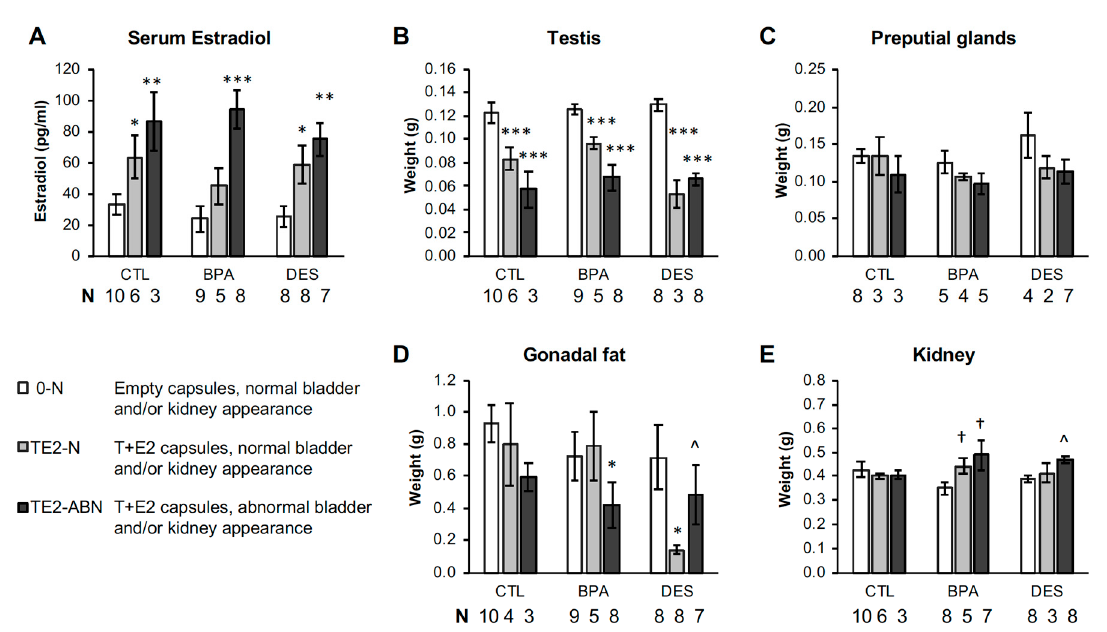
Figure 6. Serum estradiol and organ/tissue weights at necropsy in males without or with obstructed bladders and/or kidney abnormalities based on observational criteria (conducted blind to treatment group). ( A ) Serum estradiol concentrations in CTL, BPA, and DES animals with normal (N) or abnormal (ABN) bladder and / or kidneys. ( B–E ) Organ weights in the same animals (right testis, combined preputial glands, combined gonadal fat pads and right kidney). Values are mean ± SEM. ˆ P = 0.07, * P < 0.05, ** P < 0.01, *** P < 0.001 vs. CTL-0-N; † P < 0.05 vs. the same perinatal treatment without T + E2 in adulthood.